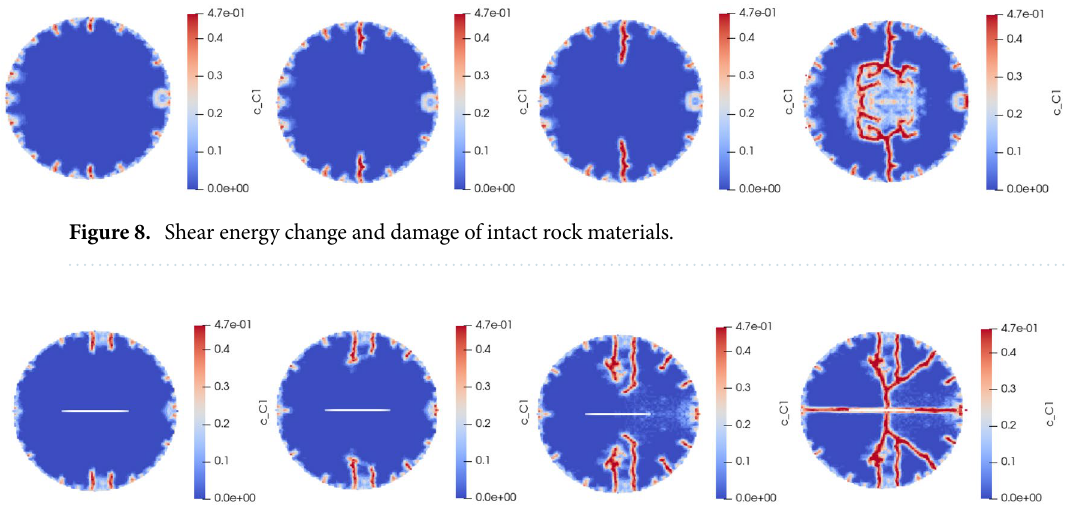
Figure 9. Shear energy change and damage of prefabricated 0° cracked rock